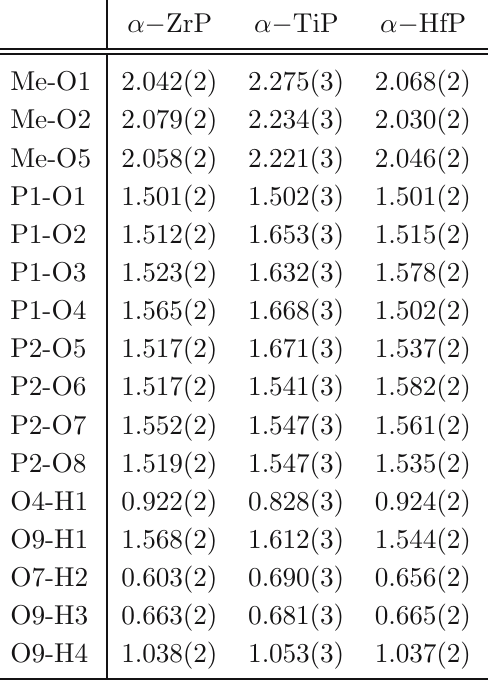
Table 6 Selected bond distances in ˚